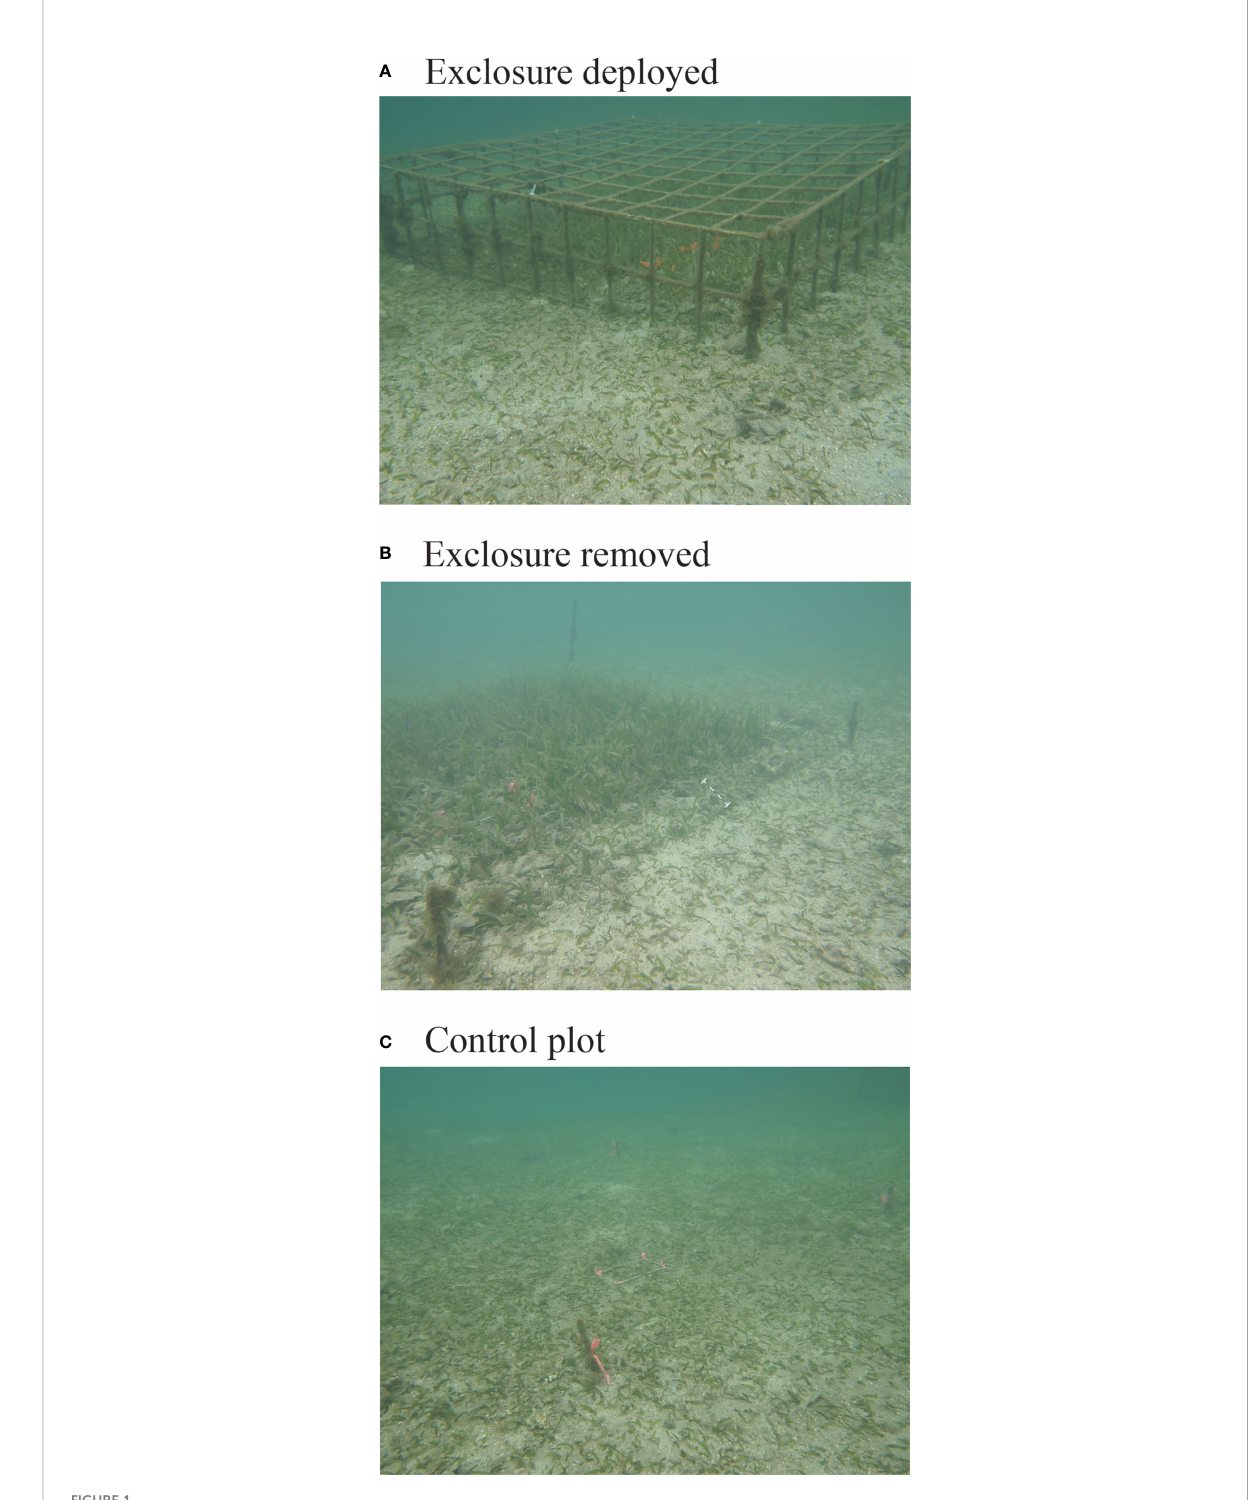
FIGURE 1 Field photos following 13 months of megaherbivore exclusion. (A) Exclosure deployed in the seagrass meadow. (B) Seagrass immediately after exclosure removal at the time of sample collection. The white dotted line highlights the transition zone near the side panels within the exclosure. (C) Control plot at the seagrass site. Flagging tape marked the rebar at the corners of the control plot and the productivity quadrats in the cages and controls marked in the week prior to sample collection. Cahuita National Park, Limo ́ n, southern Caribbean coast of Costa